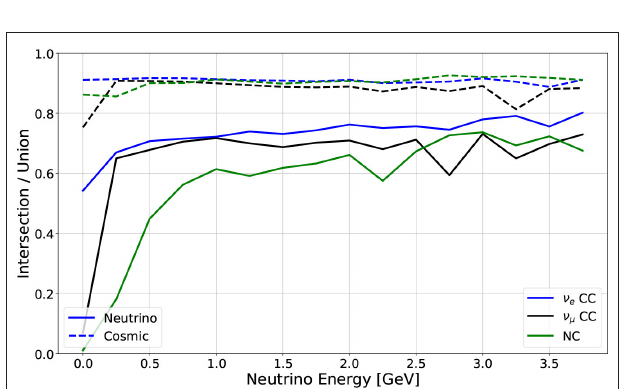
FIGURE 9 | Metric performance across neutrino interaction types, as a function of neutrino energy. The solid lines are the Intersection over Union for the neutrino predicted/labeled pixels, while the dashed lines are the Intersection over Union for the cosmic predicted/labeled pixels. Each color in this plot represents the IoU for all events containing that particular neutrino